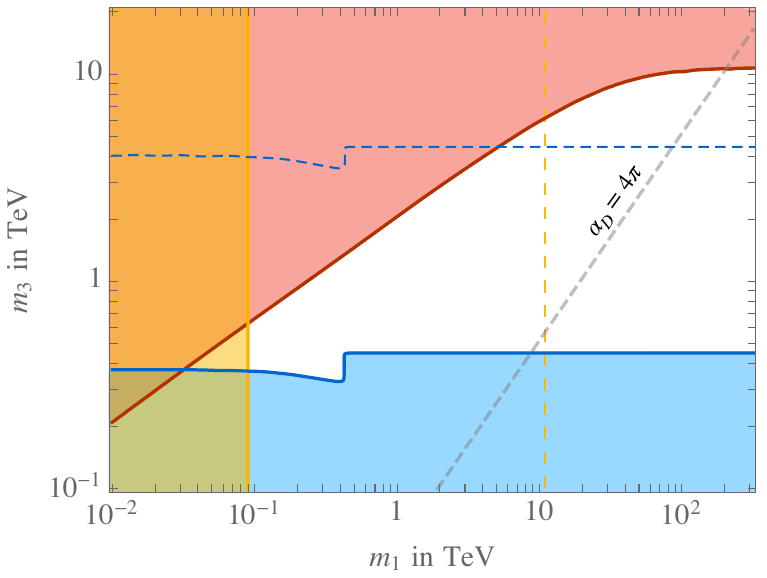
Figure 11 . Same as figure 9 for ε = 10 − 10 , which corresponds to dark photons decaying outside the detector at high-energy